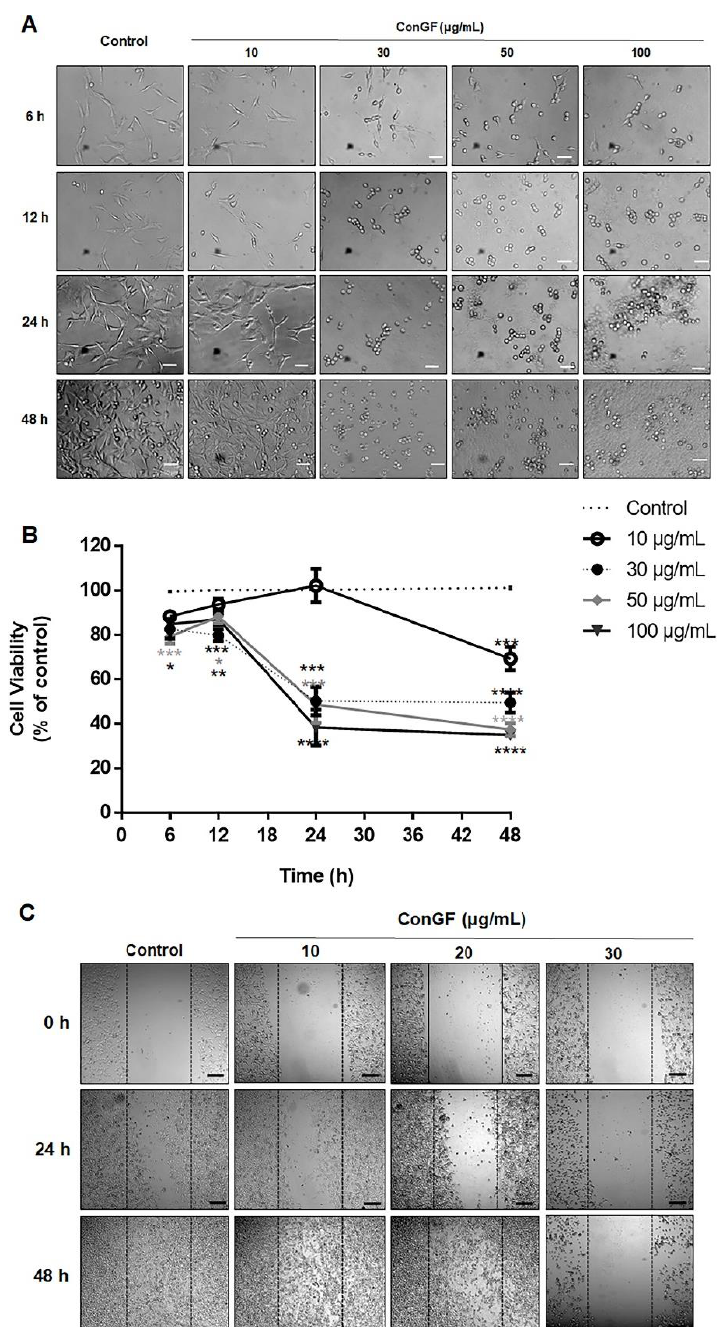
Figure 1. ConGF induces morphological alteration and decreases cell viability. C6 glioma cells were exposed for 6, 12, 24, and 48 h to vehicle (HEPES – saline buffer; control) or lectin ConGF (10, 30, 50, and 100 µg/mL). Thereafter, cell morphology and viability were performed. ( A ) Representative images from four independent experiments performed in triplicate, showing cell morphology, as evaluated by optical microscopy, in response to ConGF (bars represent 100 μm). ( B ) Cell viability evaluation after ConGF treatment, assessed by MTT assay. ( C ) Microphotographs of the wound healing at 0, 24, and 48 h after creating the wounds to evaluate cell migration (bars represent 200 µ m). The results of the MTT assay were expressed as a percentage relative to the control (dotted line). Data are presented as mean ± standard error of mean (SEM). N = 4. * p < 0.05; ** p < 0.01; *** p < 0.001; and **** p < 0.0001 indicate the statistical difference compared to the control (dotted line) by one-way ANOVA, followed by Bonferroni’s post hoc